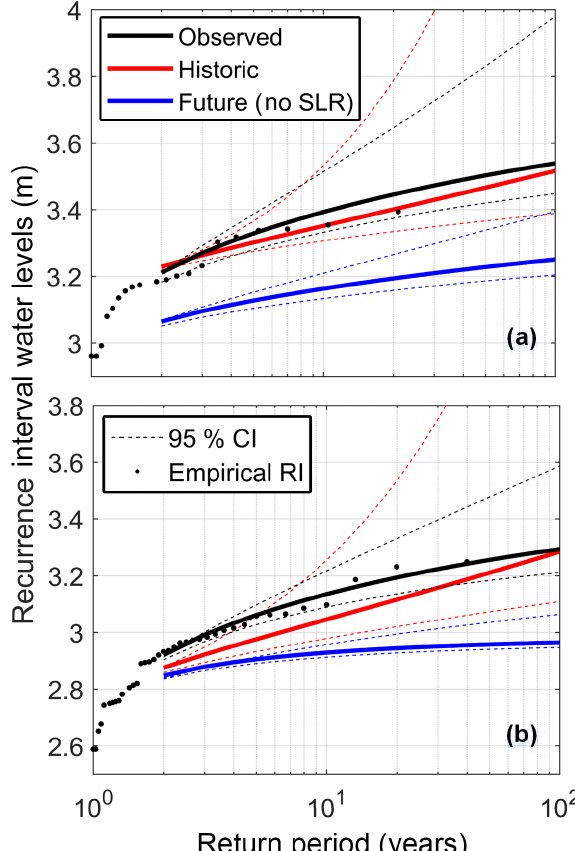
Figure 5. RIs for the Tillamook and Coos bay tide gauges, (a) and (b) , respectively. WLs are in the NAVD88 datum. Confidence in- tervals are only for statistical uncertainty in the GEV model and are calculated using a likelihood-based method (plotted as dotted lines). SLR has not been included for future RI